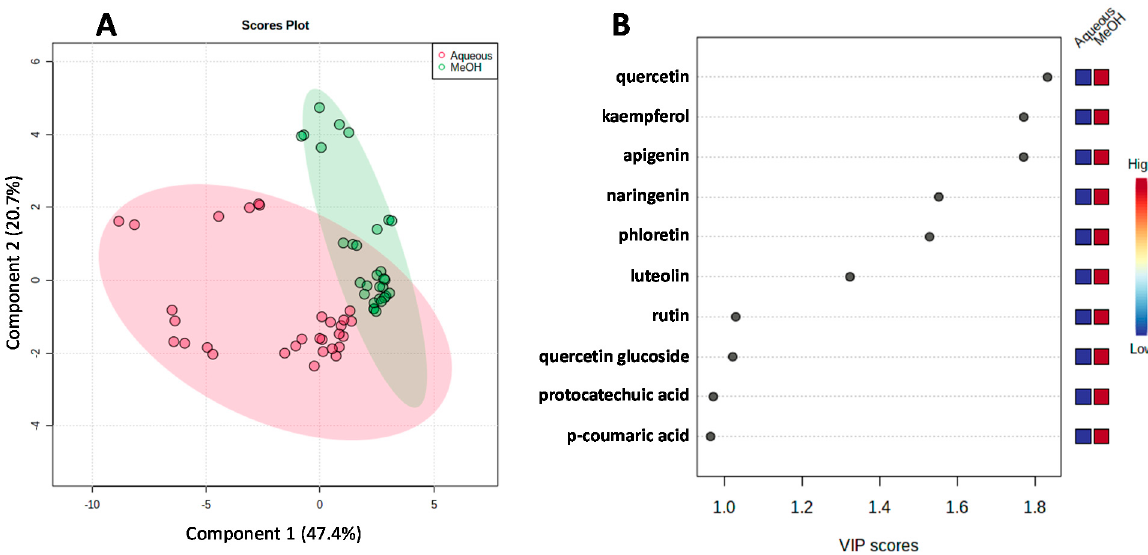
Figure 2. PLS-DA results using the phenolic data of the methanolic and aqueous extracts. Scores plot ( A ) and VIP score plot ( B ).